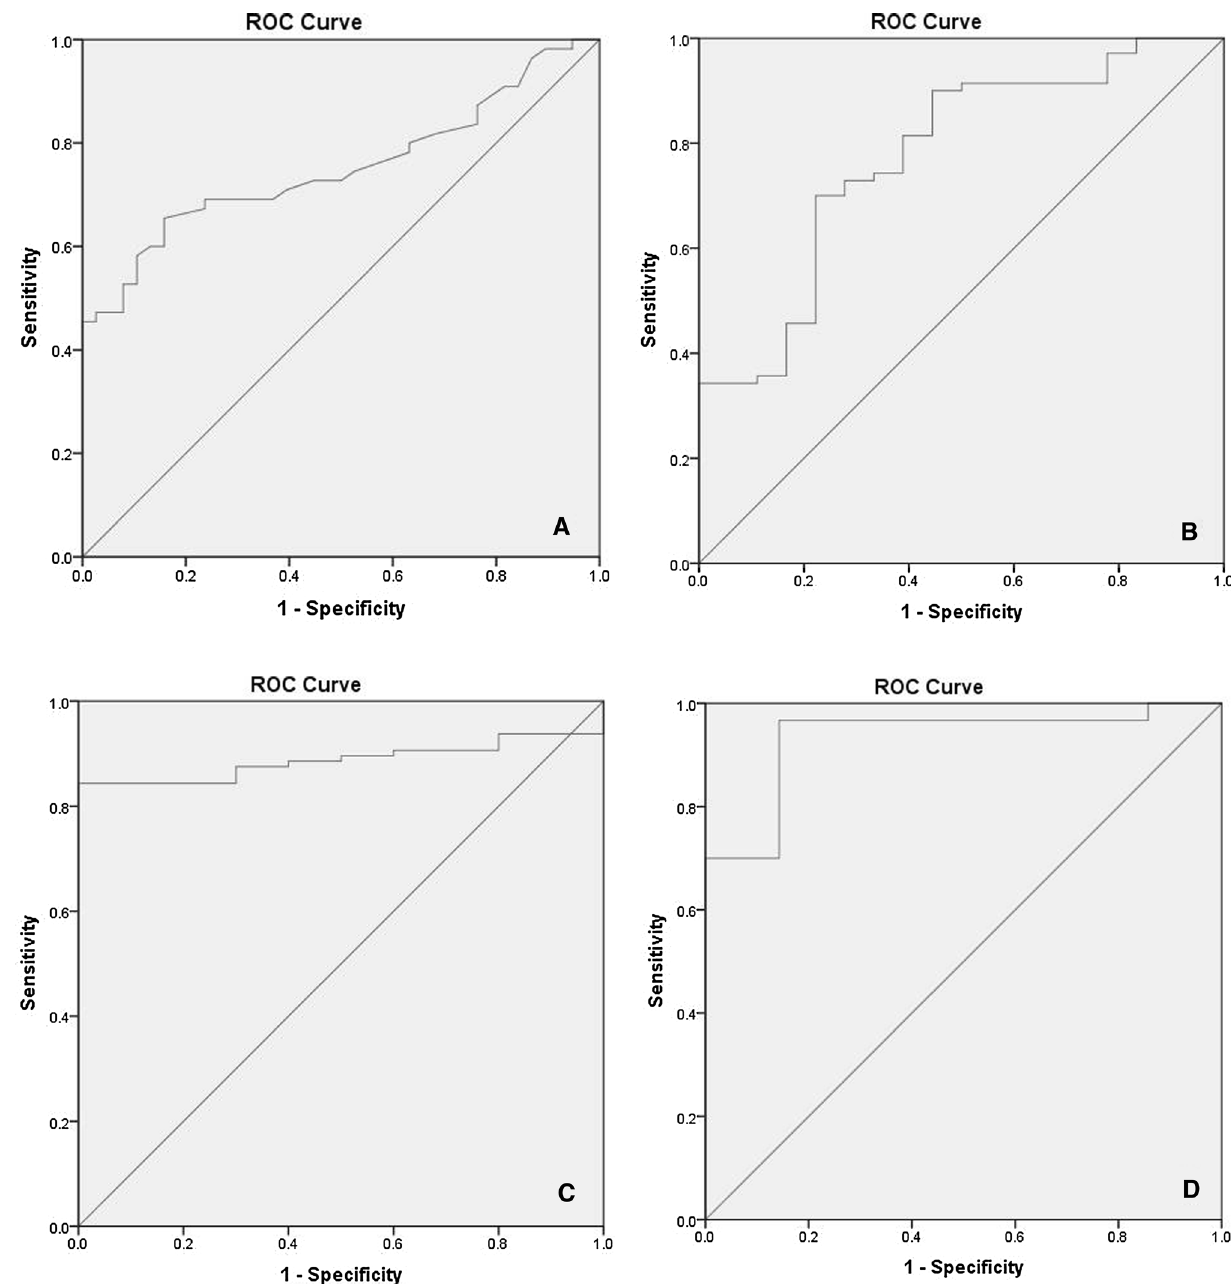
Fig. 2 The most statistically significant ROC curves of PTOA markers in plasma. The diagonal line is the reference line. a IL-6 level; b uric acid level; c NO x level; d levels of IL-6 and